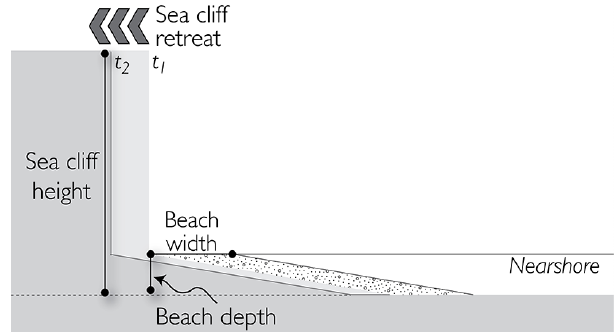
Figure 3. Cross-sectional view of the shoreface and cliff retreat variables, as defined for the modified coastal evolution model used in this